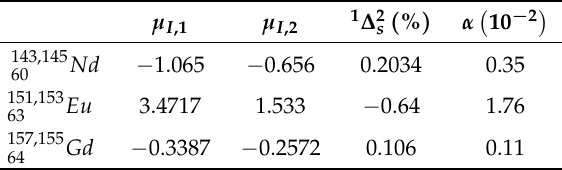
Table 5. Hyperfine anomaly in the